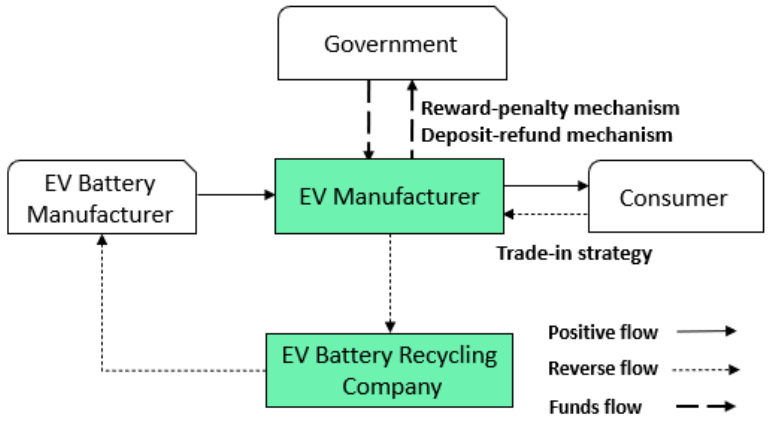
Figure 1. The framework of the recycling process.